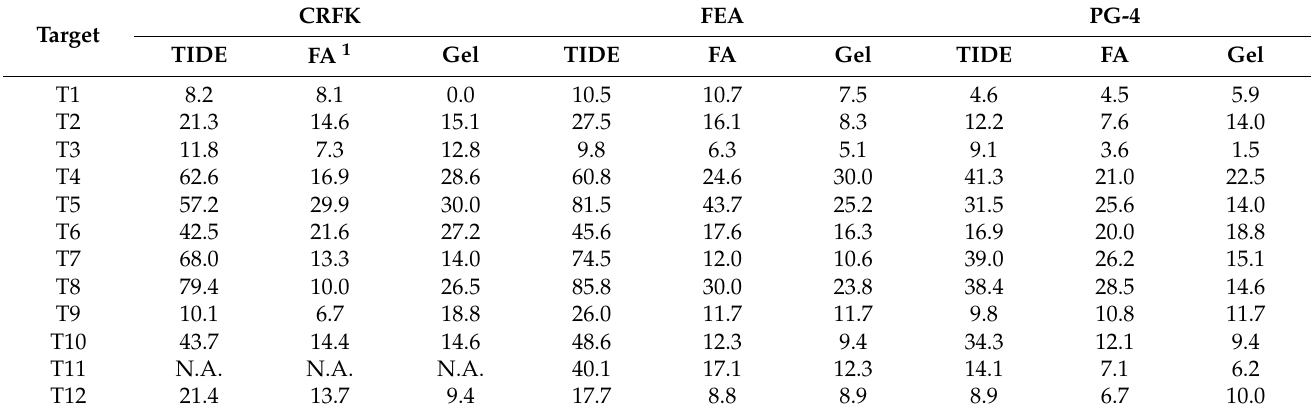
Table 3. Percentage cleavage efficiency of FeLV provirus at target sites after